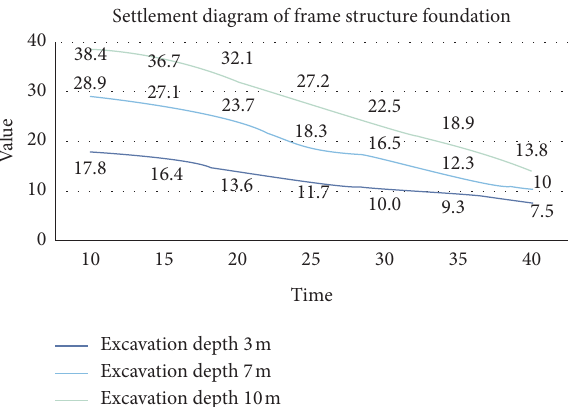
Figure 2: Settlement diagram of frame structure foundation under different excavation depth.